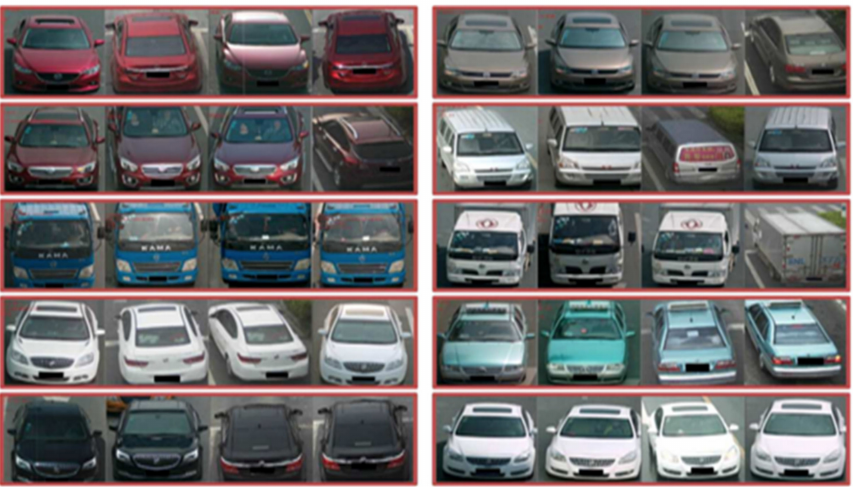
Figure 21. Depicts the sample images of vehicle-1M